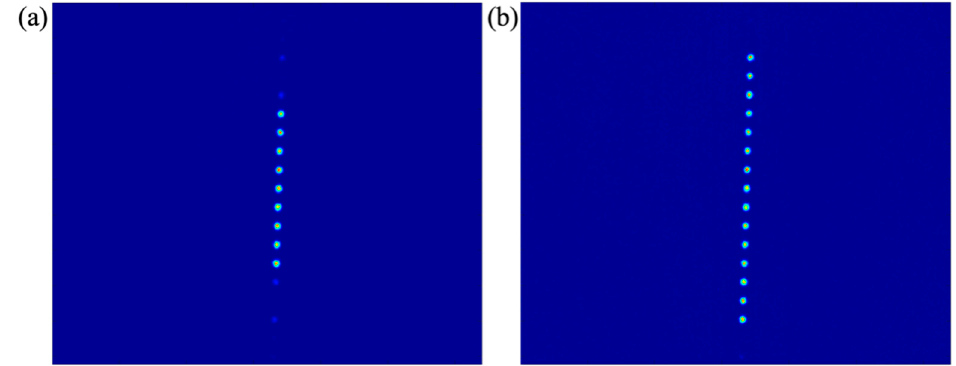
Figure 10. 2D profiles of the experimentally generated 1 × 9 ( a ) and 1 × 15 ( b ) beam spot array.